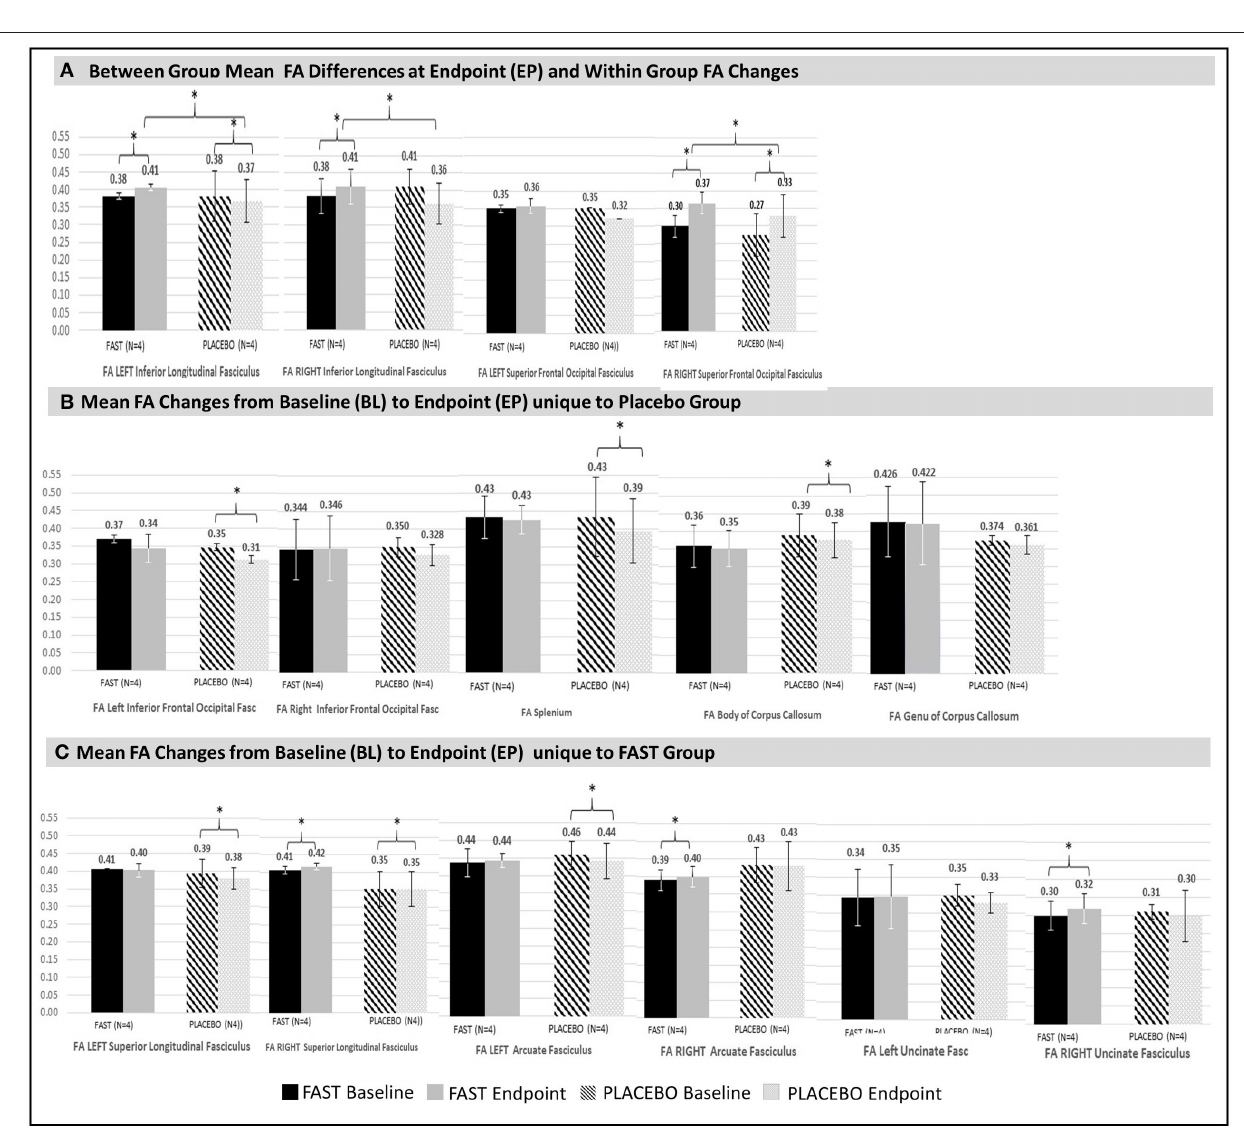
FIGURE 2 | Significant changes in structural connectivity between and within groups. Significant (denoted with * with all p < 0.00) mean FA differences between and within groups at endpoint are illustrated. For comparison purposes, non-significant FA values for contralateral tracts are also provided. Vertical bars in black and white indicate standard deviations. FAST group is denoted with solid black (baseline) and gray (endpoint) bars. Placebo group is denoted with patterned black (baseline) and patterned gray (endpoint) bars. (A) Between- and within-groups: Between-group mean FA endpoint differences and within-group FA changes from baseline to endpoint. FAST group’s FAs for the left and right ILF at endpoint are greater than same measures for Placebo group. Change in FA of the right SFOF increases for both groups, but the FAST group increases more than the placebo group. (B) Placebo group: Mean FA changes from baseline to endpoint within tracts unique to the placebo group were all decreases. Decreases occurred in the right AF, splenium, and body of corpus callosum. The left IFOF also significantly declined, but at baseline this was significantly lower for the placebo group. Thus, the left IFOF finding is not considered for interpretation. Although there were no significant changes for the genu, this tract is shown to facilitate evaluation of all colossal fiber tracts. (C) FAST group: Mean FA changes from baseline to endpoint that are unique for the FAST group occurred within three right hemisphere tracts: right SLF, the right arcuate fasciculus (AF), and the right uncinate fasciculus (UF).